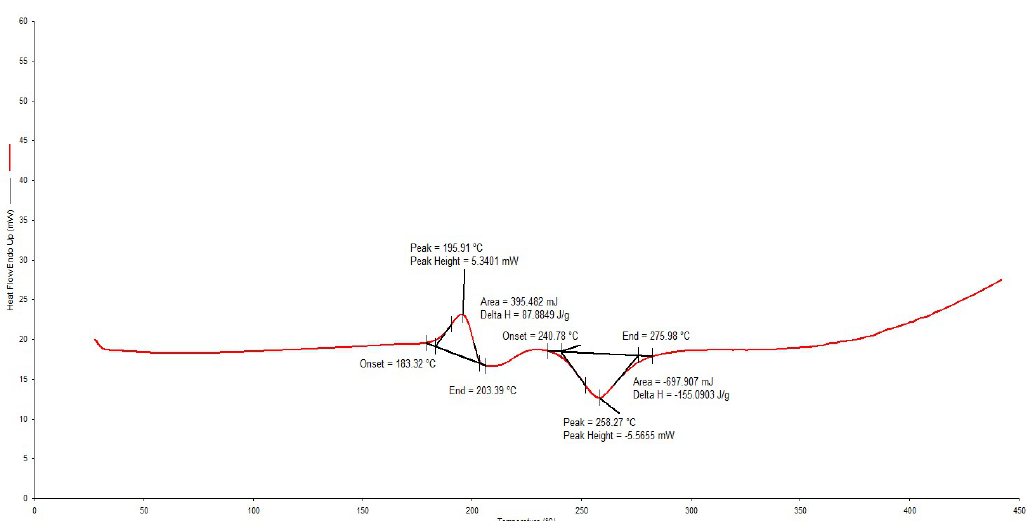
Figure 4. Typical DSC thermogram for RIF generated at a heating rate of 10 °C/min over the temperature range 30–400 °C.